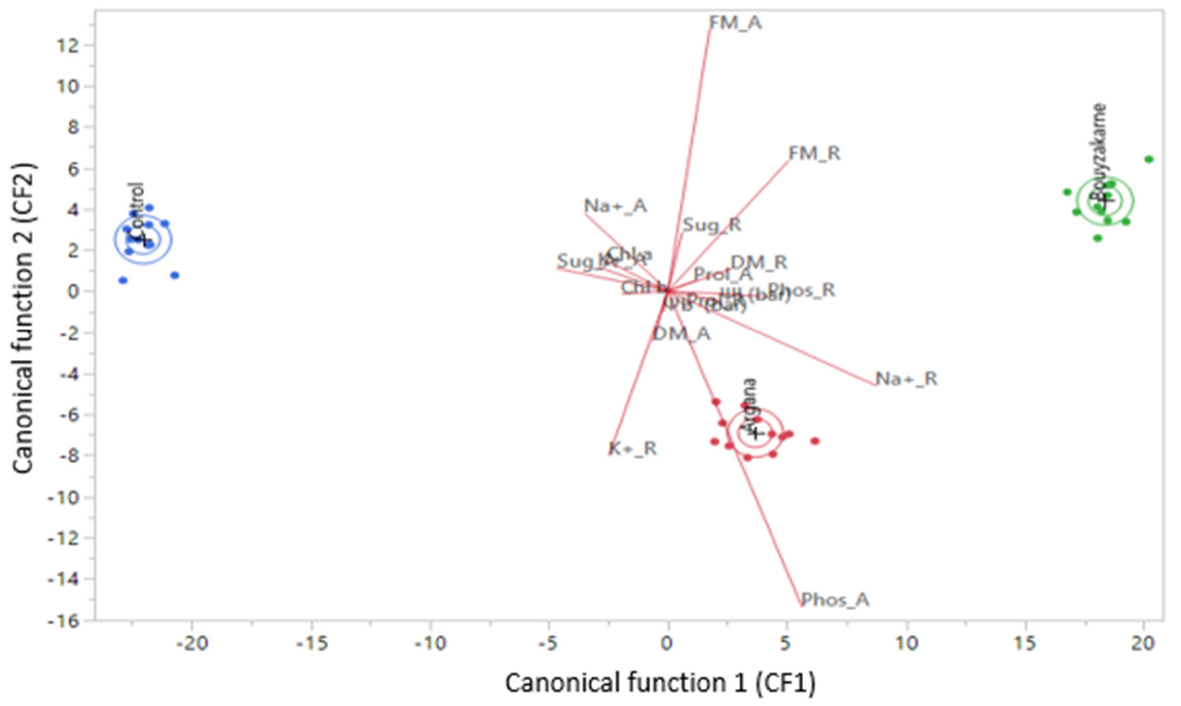
Figure 10. Two-dimensional point cloud showing the separation of the inoculates studied according to the two gradients of the discriminating functions obtained by ACD for the parameters recorded in the aerial and root parts (FM_A: aerial fresh matter, DM_A: aerial dry matter, Sug_A: aerial sugar, Prol_A: aerial proline, Phos_A: aerial phosphorus, FM_R: root fresh matter, DM_R: root dry matter, Sug_R: root sugar, Prol_R: root proline, Phos_R: root phosphorus).